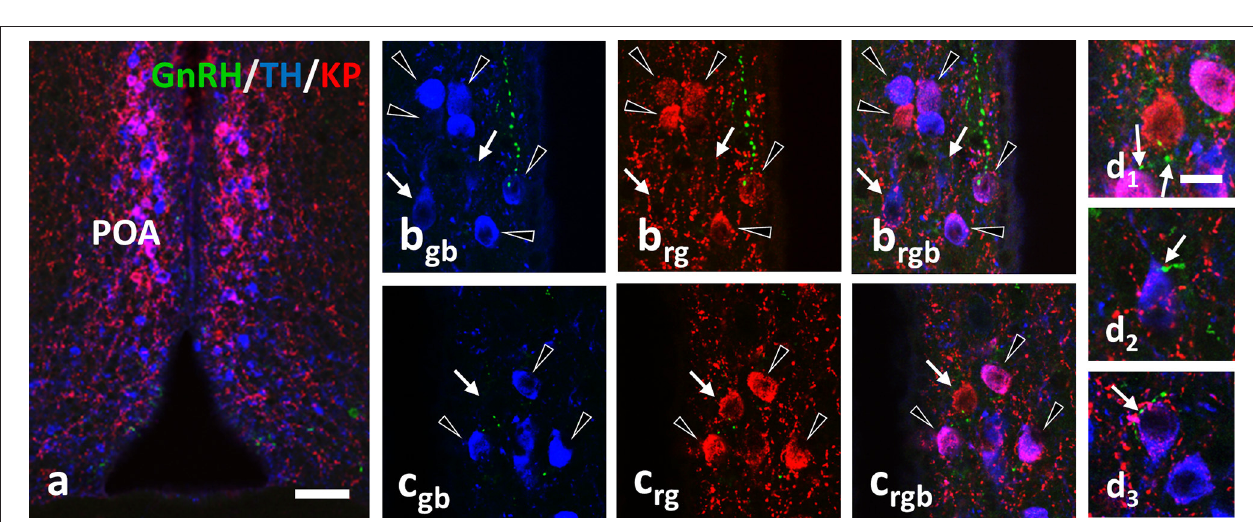
FIGURE 3 | Immunohistochemical triple labeling for GnRH (green), TH (blue) and KP (red) in the POA, where the majority of TH neurons are also immunoreactive for KP (a ; co-localization in purple). Besides double-labeled neurons (arrowheads), single-labeled for TH (arrows in b) or KP (arrow in c) are also present. The GnRH-IR varicosities form appositions (arrows) on all three phenotypes of neurons (d1–d3). Scale bar in (a) is 50 µ m; in (bgb– d3) 10 µ m.